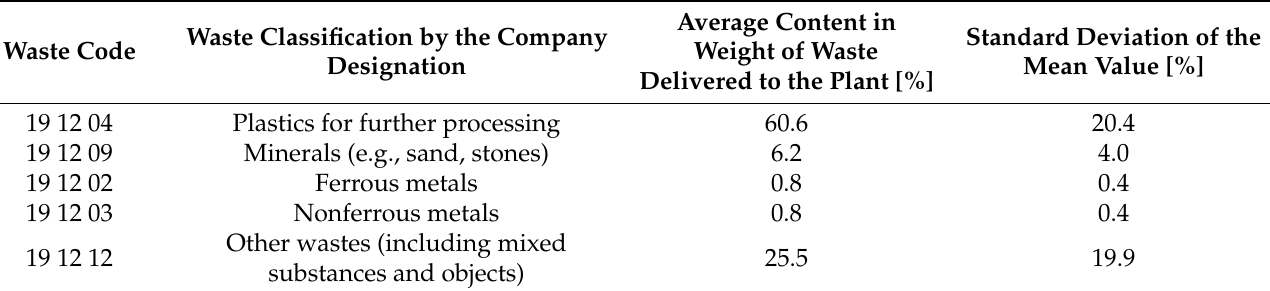
Table 2. Characteristics of the waste to be recycled.